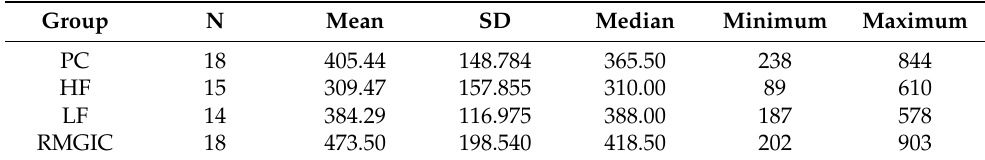
Table 2. Descriptive statistics of fracture load (in Newtons).